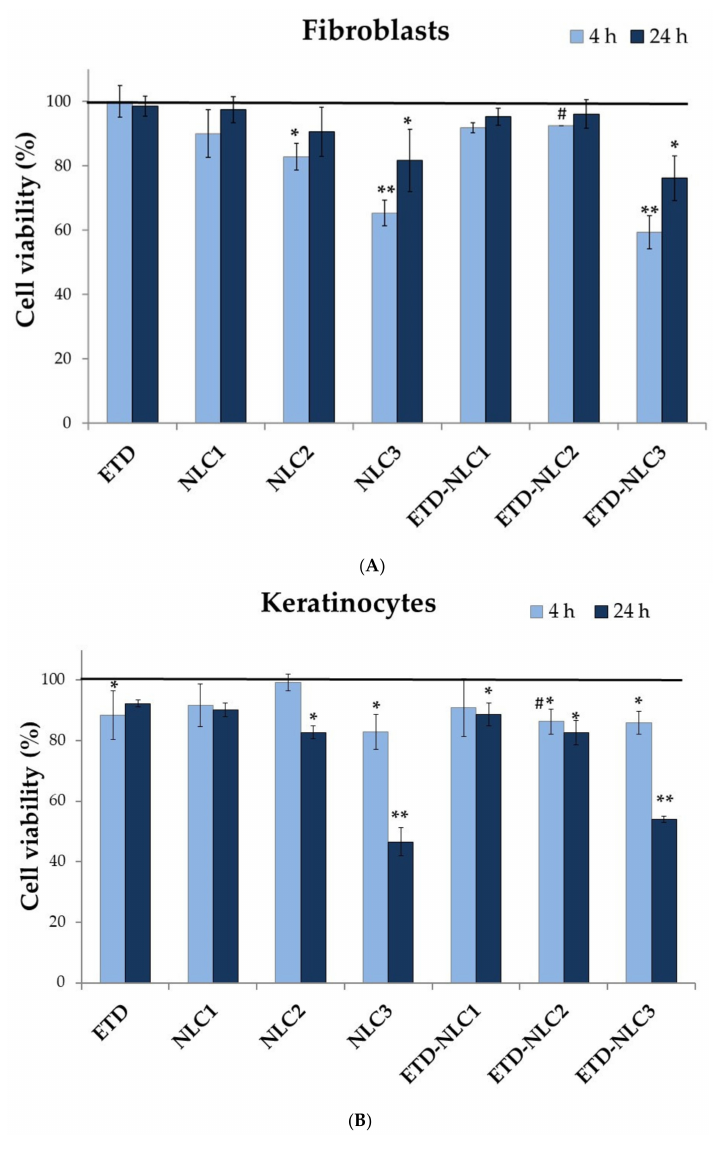
Figure 6. Cell viability of ( A ) fibroblasts and ( B ) keratinocytes, treated with: free ETD, free NLC and ETD-loaded NLC (* significance threshold at p -values < 0.05 and ** significance threshold at p -values < 0.01 in comparison to control—cells incubated only with medium; # p < 0.05 in comparison to NLC without ETD). Data are shown as mean ± SD, n =